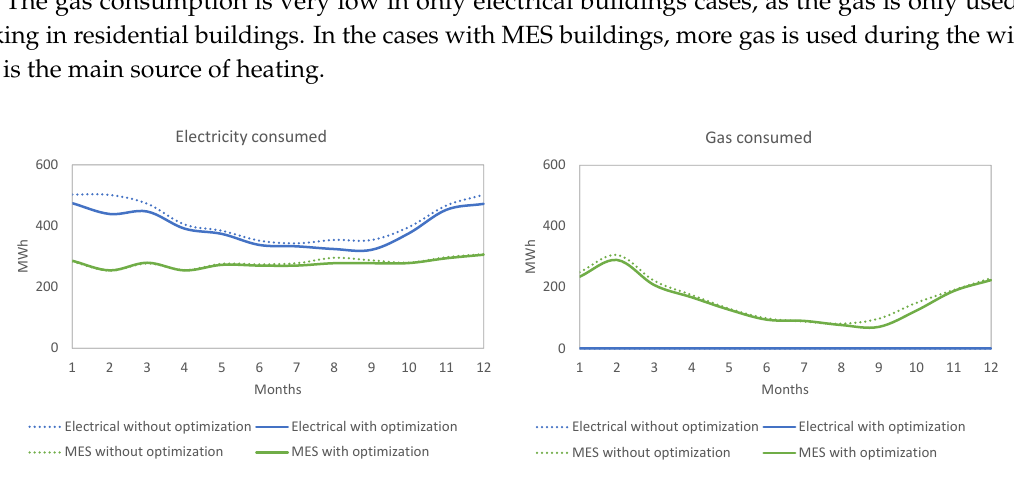
Figure 21. Annual consumption of electricity and gas. Table 3. Annual consumption of electricity and gas in each